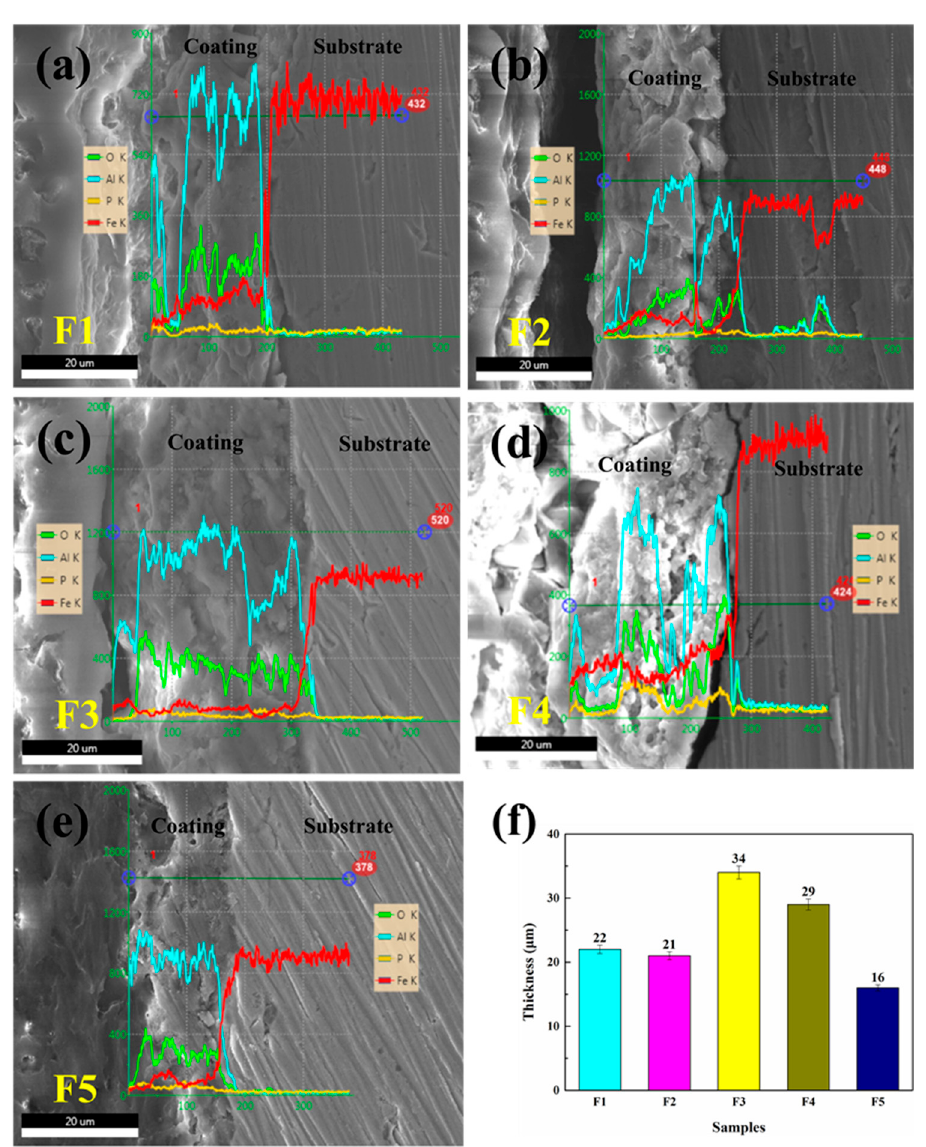
Figure 3. Cross section SEM images (5000×) of MAO coatings and EDS line scan distribution curve: ( a ) F1; ( b ) F2; ( c ) F3; ( d ) F4; ( e ) F5, and ( f ) the thickness of the coatings under different negative voltages.